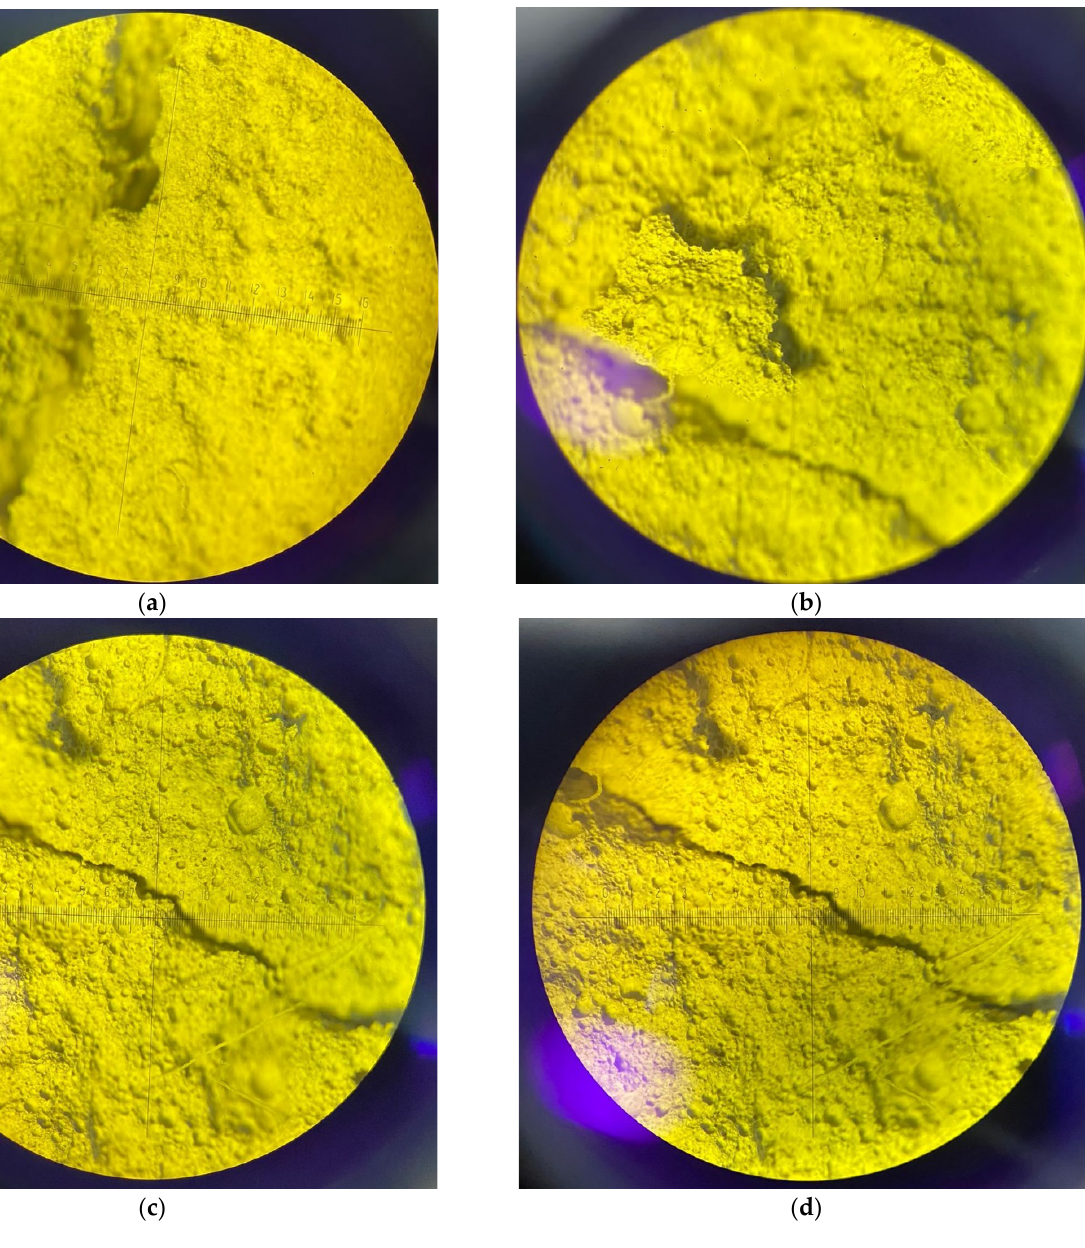
Figure 15. Photographs of the microstructure of the obtained sample of fiber foam concrete nanomodified with microsilica with a magnification of 6 times: ( a ) the nature of the destruction of concrete and the exposure of reinforcing fibers at the fracture of the sample; ( b ) the nature of the displacement of structural fragments in the deformation zones during ductile fracture; ( c ) the nature of the crack at the initial stage of failure with a small crack opening; ( d ) demonstration of the stability of the concrete structure to maintain the width of the crack opening with increasing load (performed on an MBS-10 microscope).